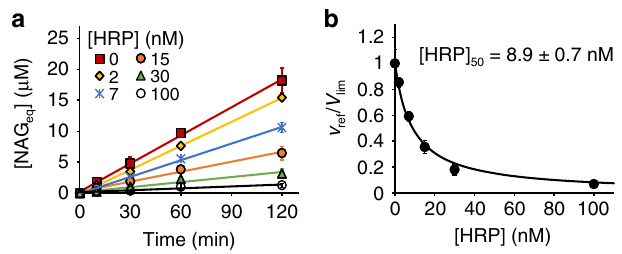
Fig. 2 Competition between Sm AA10A and HRP. All experiments were made in Bis – Tris buffer (50 mM, pH 6.1) at 25 °C and contained CNWs (1.0 g L − 1 ), AscA (1.0 mM), Sm AA10A (42 nM), and ABTS (0.2 mM). a Progress curves for the release of soluble products (in NAG eq ) in the presence of horseradish peroxidase (HRP) at different concentrations, as indicated in the plot. Solid lines show linear regression of the data. The slopes of the lines correspond to the rate of the reference reaction ( v ref ). b Dependency of v ref / V lim on [HRP]. The solid line shows non-linear regression of the data according to Eq. (5). Data are presented as average values ( n = 3, independent experiments) and error bars show SD. Source data are provided as a Source Data fi le.